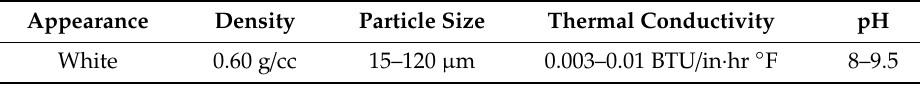
Table 3. Technical characteristics of hollow glass